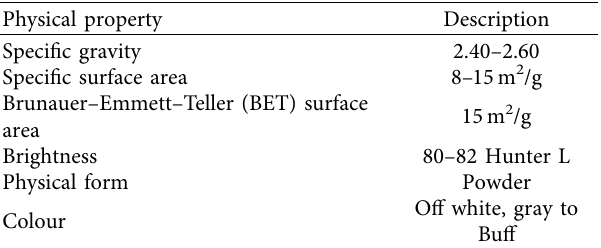
Figure 1: Schematic diagram showing the methodology, results, and recommendations. Table 2: Physical properties of metakaolin